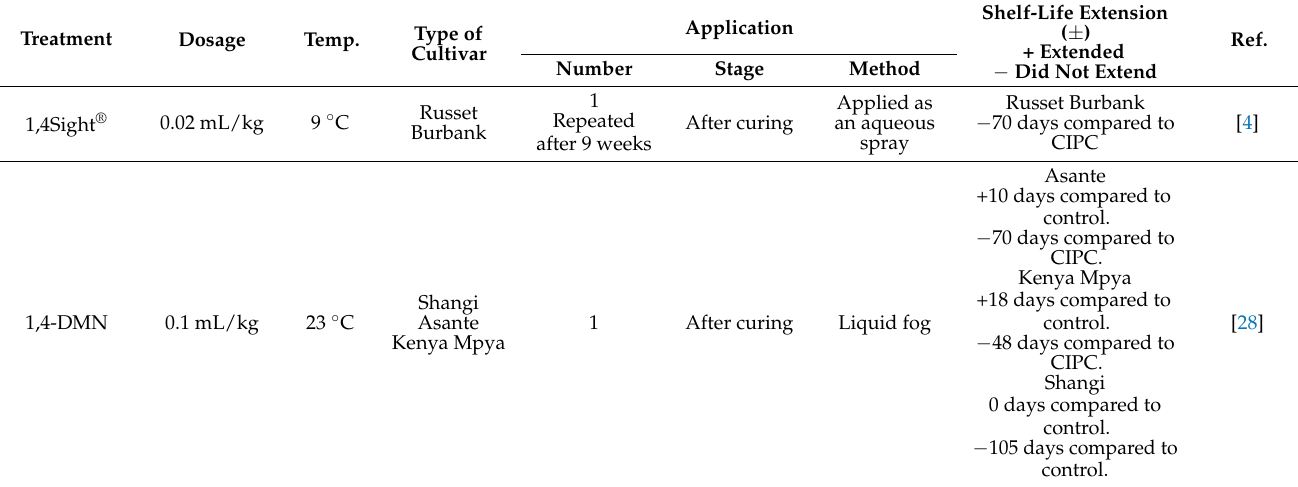
Table 1. Shelf-life studies showing the efficacy of 1,4-DMN and 1,4Sight ® as alternative sprout suppressants. Treatment